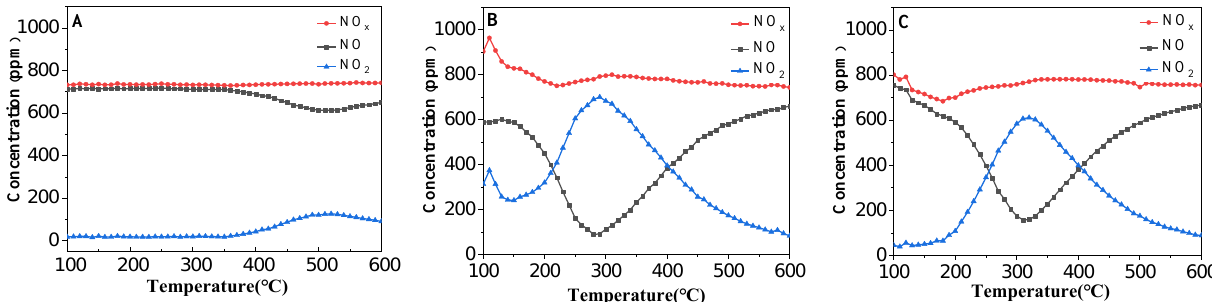
Figure 6. NO x , NO, and NO 2 concentration over M-TSO support ( A ), MnCeO x /M-TSO catalyst ( B ), and K 0.5 MnCeO x /M- TSO catalyst ( C ).